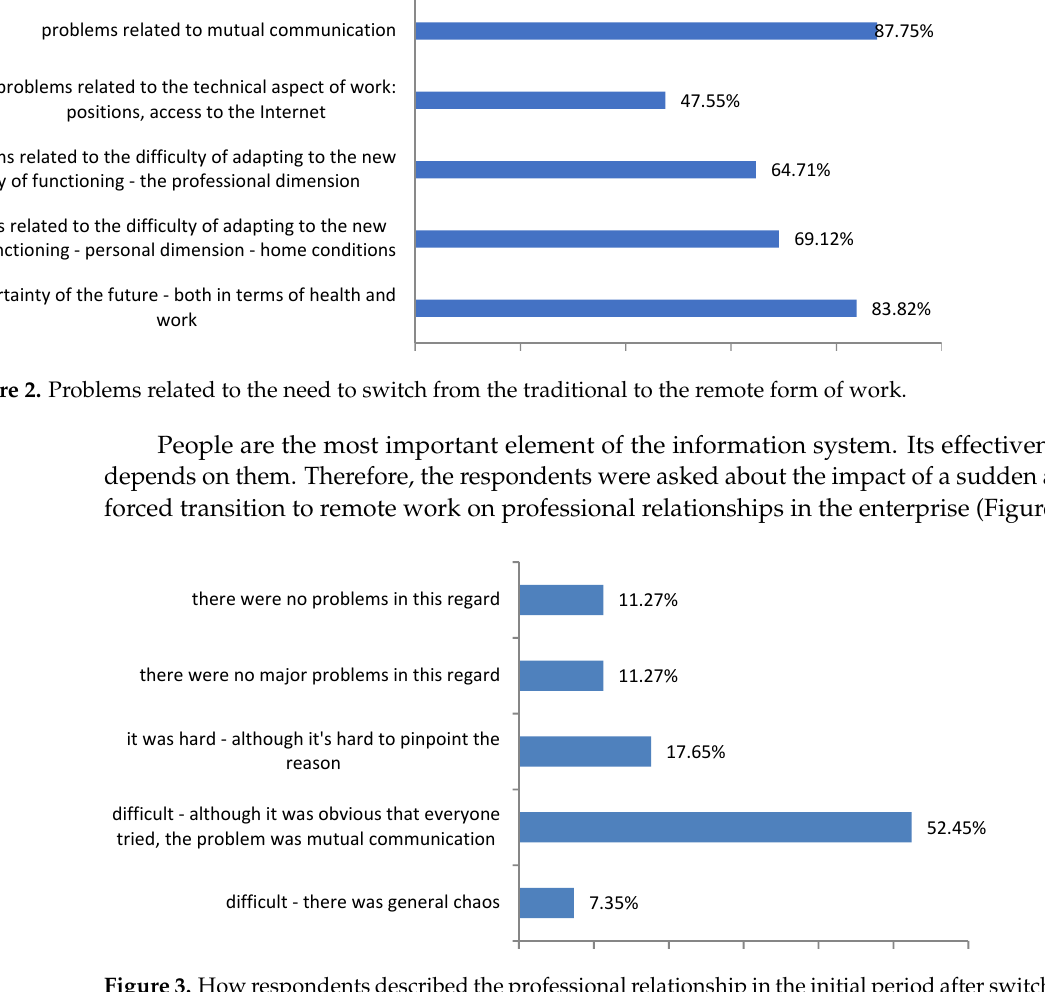
Figure 3. How respondents described the professional relationship in the initial period after switching to the remote mode.